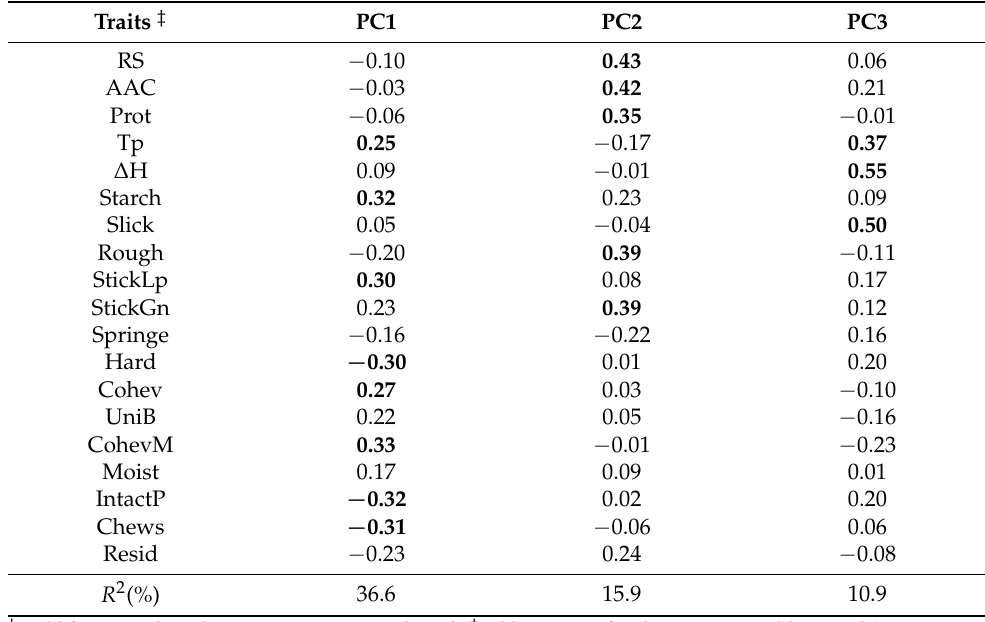
Table 7. PCA analysis of traits of grain quality and texture attributes †